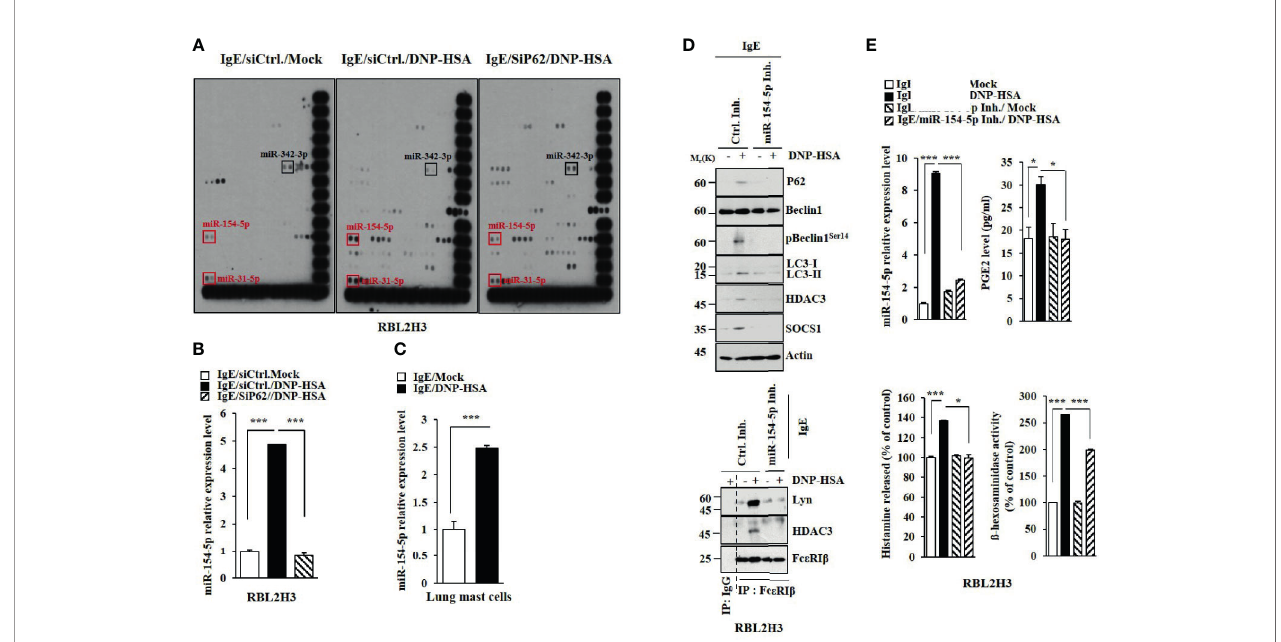
FIGURE 1 | MiR-154-5p is necessary for in vitro allergic reactions. (A) RBL2H3 cells were transfected with indicated siRNA (each at 10 nM). The next day, cells were then sensitized with DNP-speci fi c IgE (100 ng/ml) for 24 h followed by stimulation with DNP-HSA (100 ng/ml) for 1 h. miRNA array analysis was performed. The siCtrl. denotes control (negative) siRNA. (B) QRT-PCR analysis was performed. *** p <0.001. Average values of three independent experiments are shown. (C) IgE-sensitized lung mast cells were treated with DNP-HSA for 1 h. QRT-PCR was performed. *** p <0.001. Average values of three independent experiments are shown. (D) RBL2H3 cells were transfected with the indicated inhibitor (each at 10 nM). The next day, cells were sensitized with DNP-speci fi c IgE for 24 h followed by stimulation with DNP-HSA for 1 h. Immunoprecipitation with isotype-matched IgG was also performed. Representative blots of three independent experiments are shown. (E) Levels of PGE2 and the amount of histamine released into growth medium were determined. ß-hexosaminidase activity assays and qRT-PCR were also performed. * p <0.05; *** p <0.001. Average values of three independent experiments are